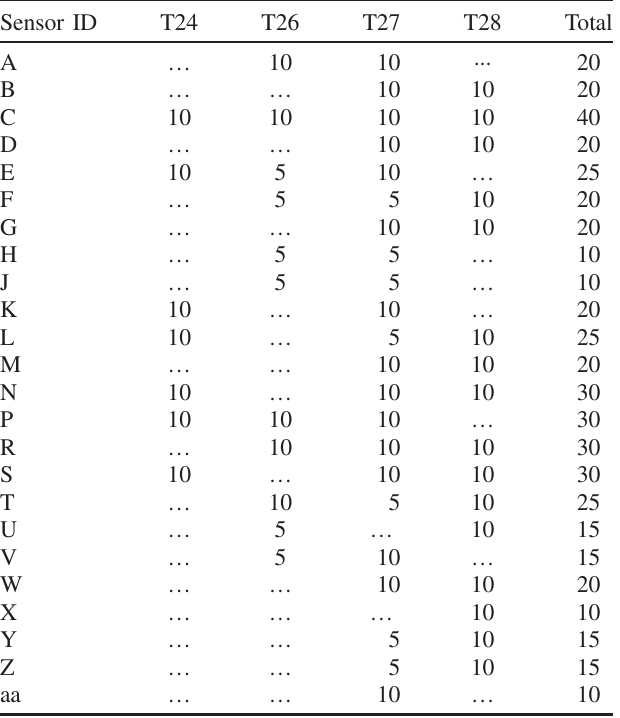
TABLE III. Number of strain measurements from each jet-flow target sensor.